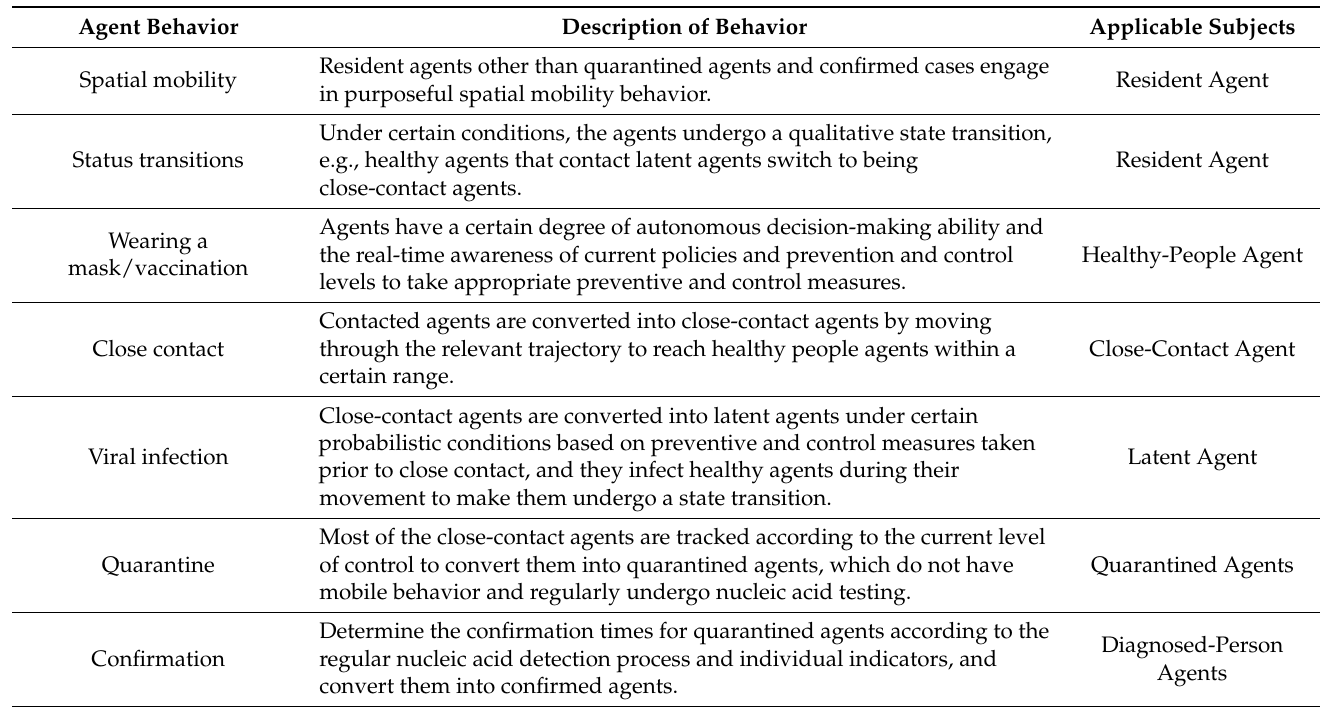
Table 1. Agent behaviors and